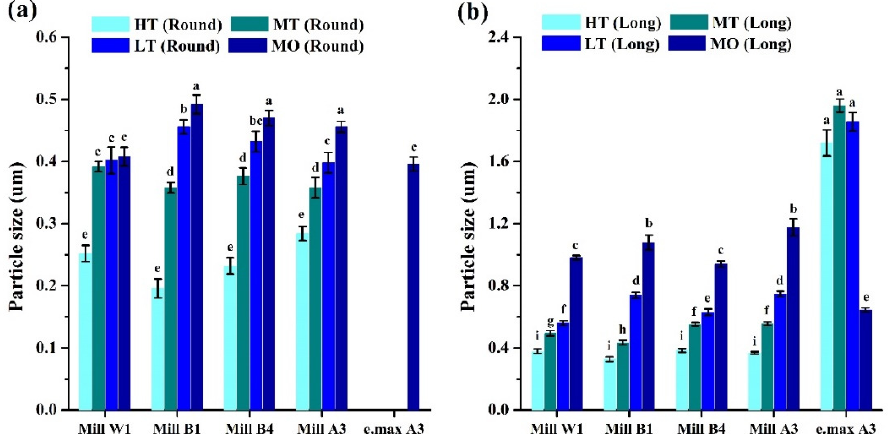
Figure 7. Particle sizes of different translucency extents and colors. ( a ) Round and ( b ) long. Means with different letters differ significantly ( p < 0.05, mean ± SD, n = 10).